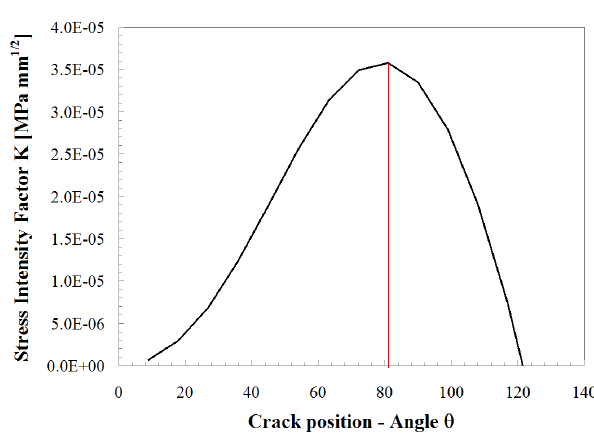
Figure 24: Analytical solution for K (bending stress 1 MPa).